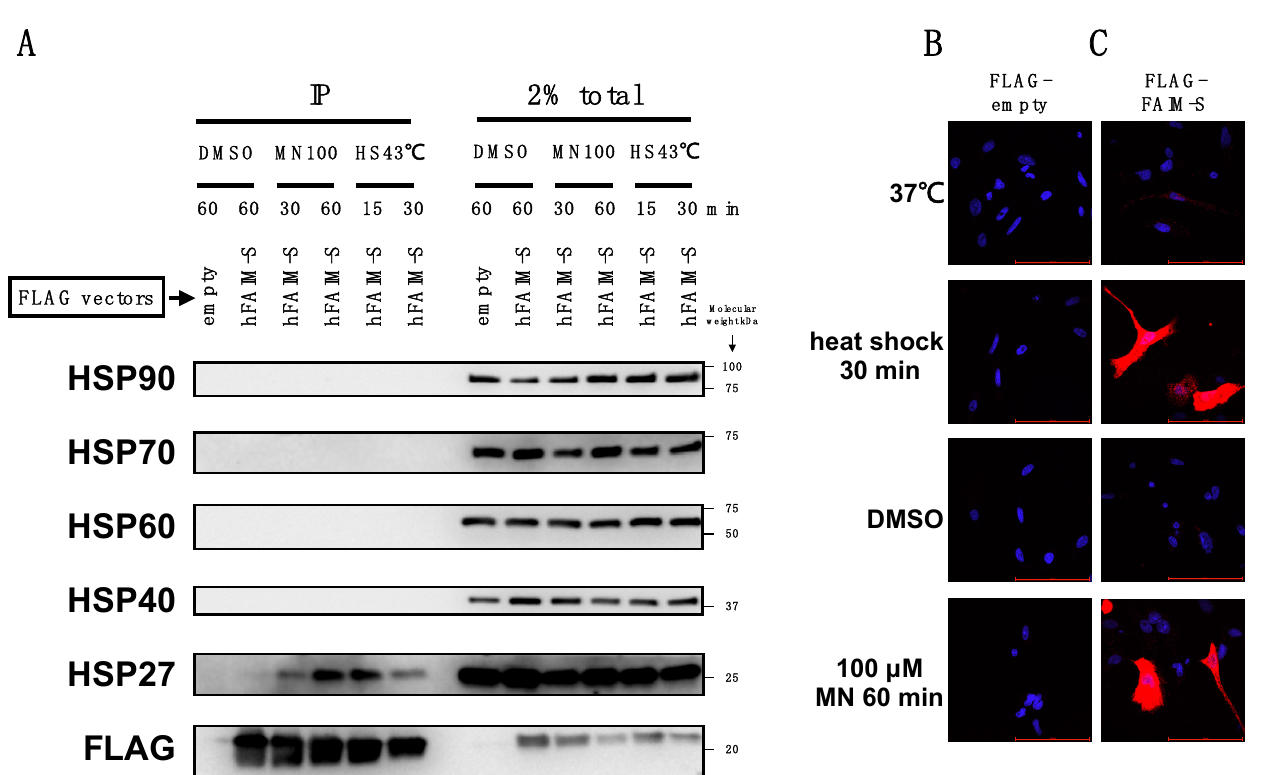
Figure 4. FAIM associates with HSP27 upon cellular stress. ( A ). FLAG-tagged FAIM-S was transiently transfected into FAIM-KO HeLa cells. Two days after the transfection, cells were harvested with or without stress induction provided by incubation with menadione (MN) at 100 μ M or heat shock (HS) at 43 °C for the indicated times, and lysed in RIPA buffer. Samples were immunoprecipitated with anti-FLAG and then Western blotted for HSP proteins. ( B , C ). FAIM-KO HeLa cells transiently transfected with FLAG-tagged vectors were incubated at 43 °C for 30 min, with the DMSO diluent for menadione for 60 min, and with menadione at 100 μ M (MN) for 60 min. Cells were then fixed, permeabilized, and a PLA reaction was performed. Red dots indicate positive PLA signals. The cell nuclei were stained blue with DAPI. Scale bar, 100 μ m. Similar results were obtained from at least 3 independent experiments.